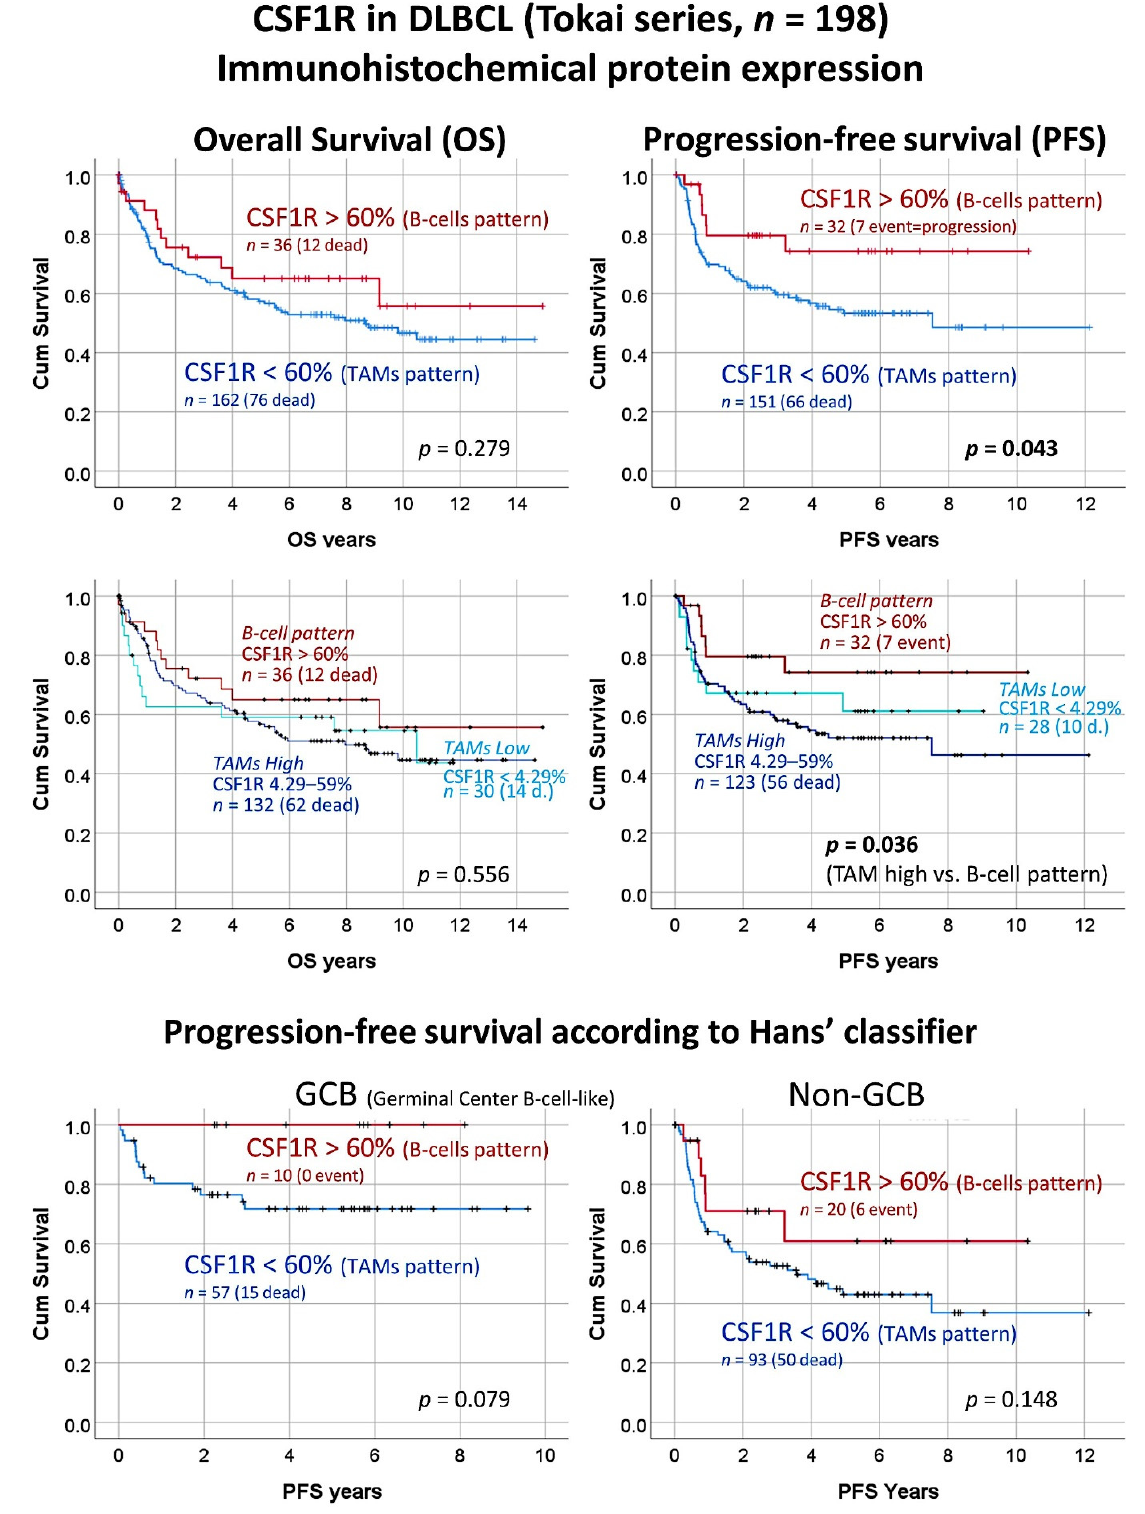
Figure 3. Correlation between CSF1R protein levels and survival of the patients (Tokai series). A correlation with the progression-free survival was found according to the CSF1R expression. Correlation between the CSF1R protein levels and the progression-free survival according to the cell-of-origin molecular classification (Hans‘ classifier) was also performed. Despite that, the curves are separated. No statistically significant correlation with the progression-free survival was found. OS, overall survival; PFS, progression-free survival; GCB, germinal center B-cell-like.